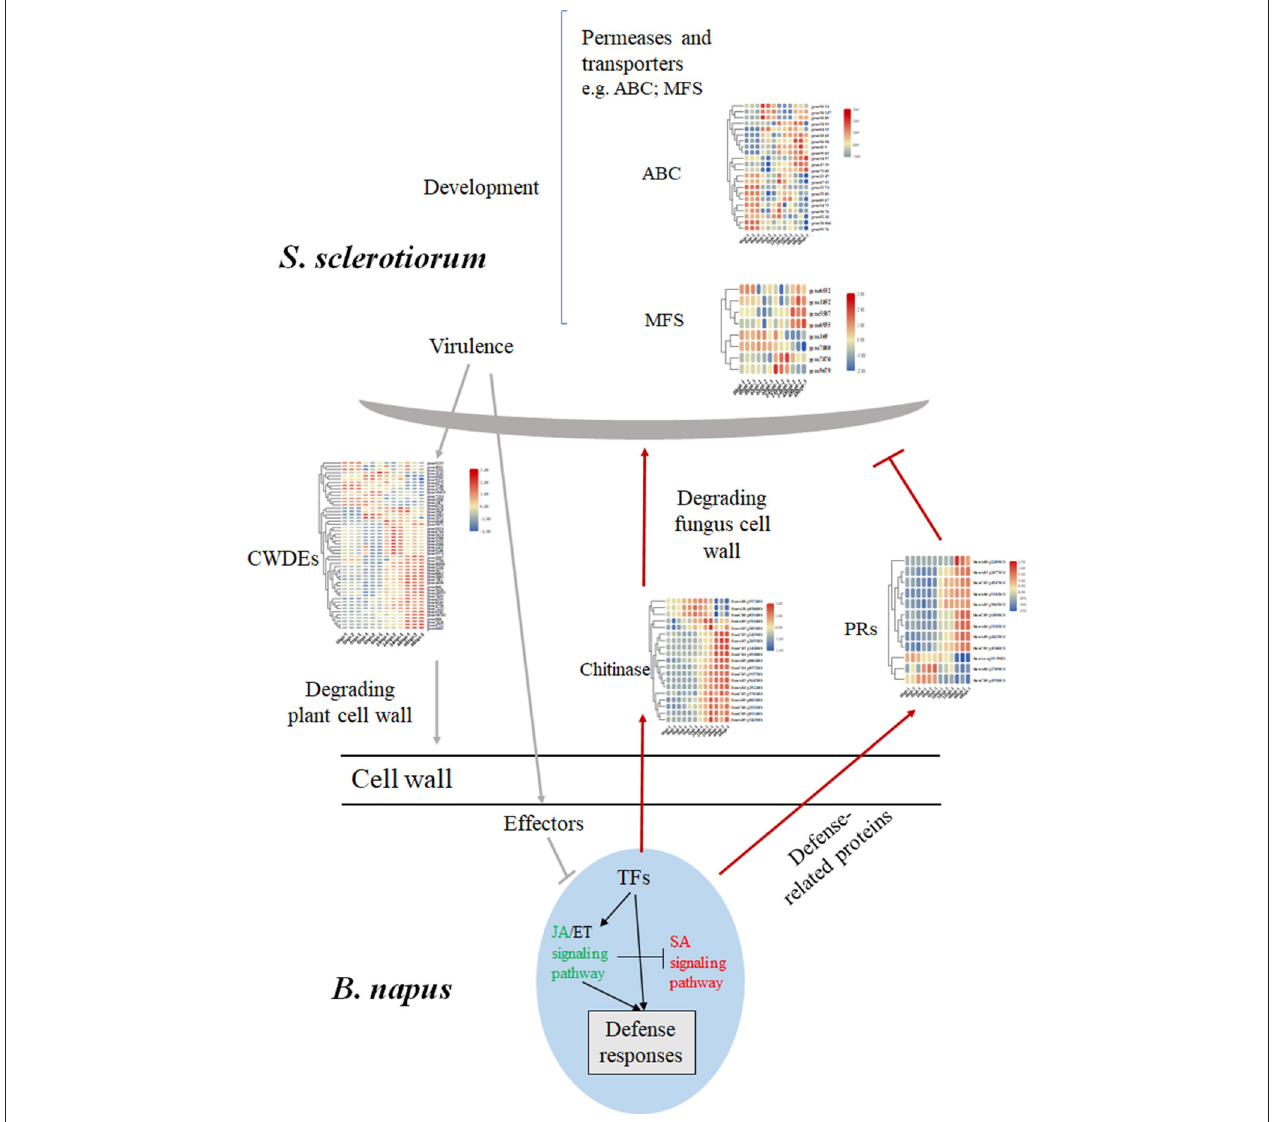
FIGURE 7 | Differential changed genes involved in the major molecular mechanisms of B. napus – S. sclerotiorum interactions. The SA signaling pathway colored in red indicated an activation, while the JA signaling pathway colored in green indicated repression in our study. Abbreviations: CWDE, cell wall-degrading enzymes; PRs, pathogen-related proteins; TF, transcription